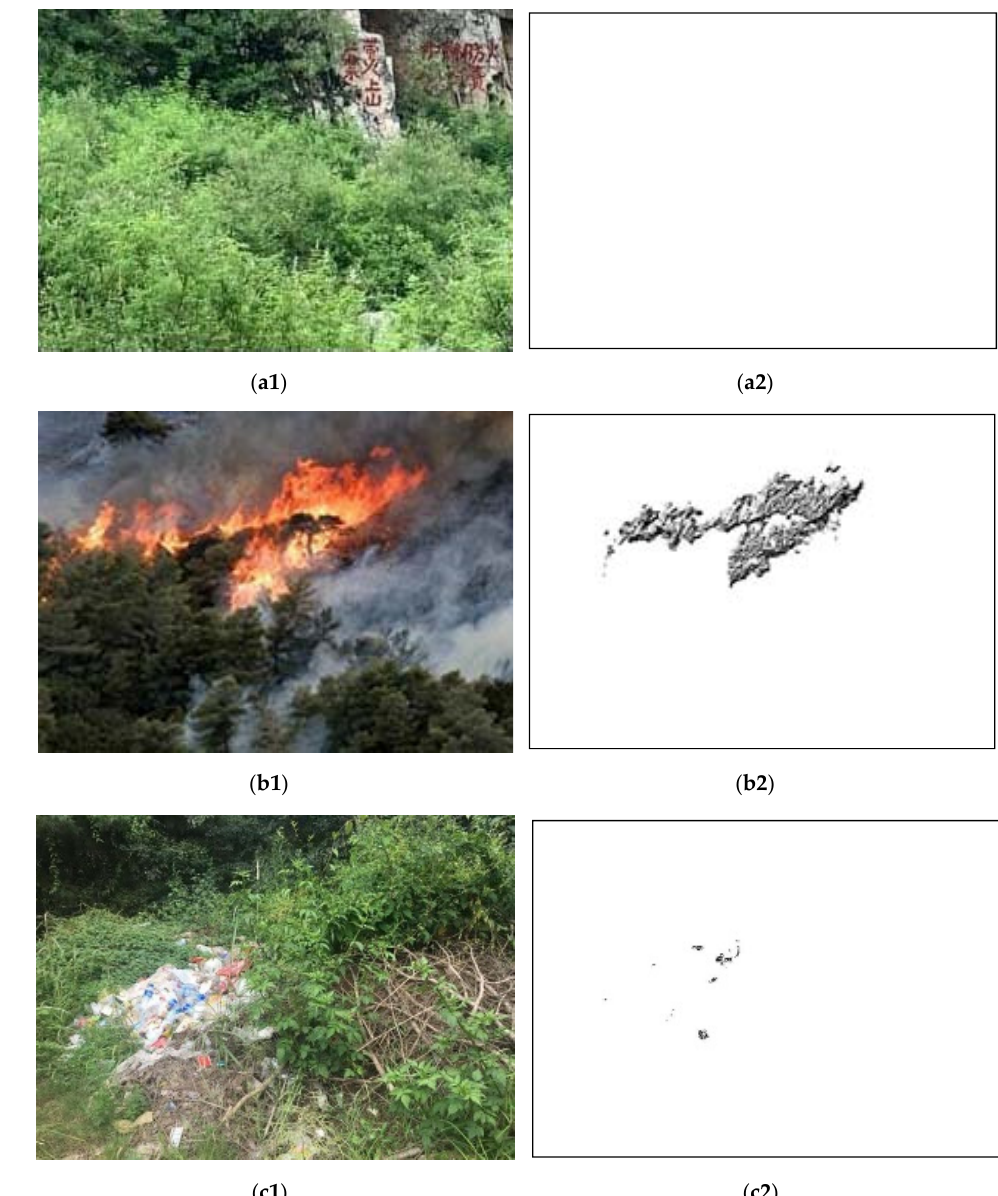
Figure 7. LBP-extracted image textures of forest fire images: ( a1 ) forest image without fire; ( a2 ) LBP- extracted image textures of forest image without fire; ( b1 ) forest image with fire; ( b2 ) LBP-extracted image textures of forest image with fire; ( c1 ) forest image with fire-like interference; ( c2 ) LBP-extracted image textures of forest image with fire-like interference.